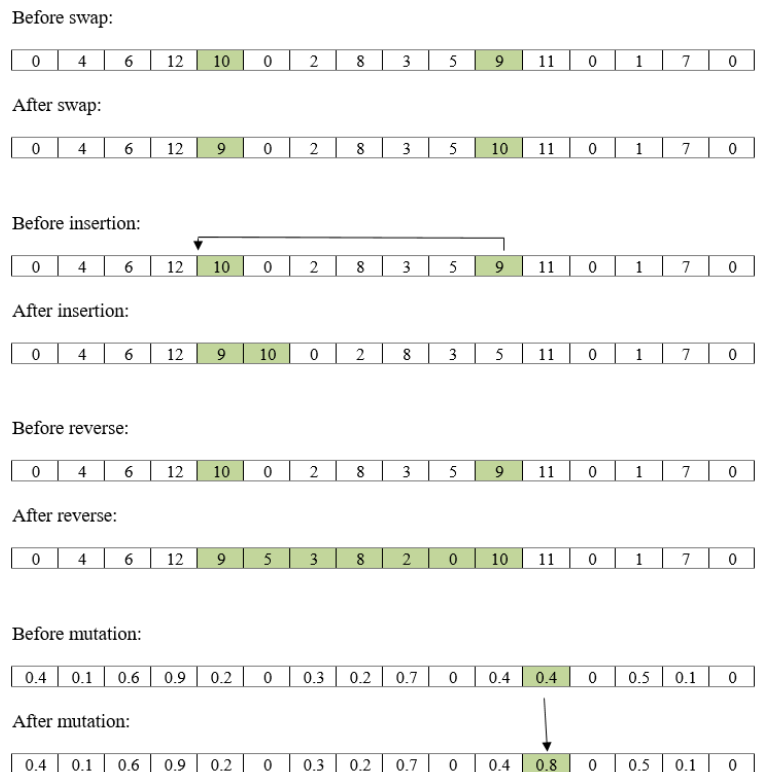
Figure 3. An illustration of swap, insertion, reverse, and mutation moves.